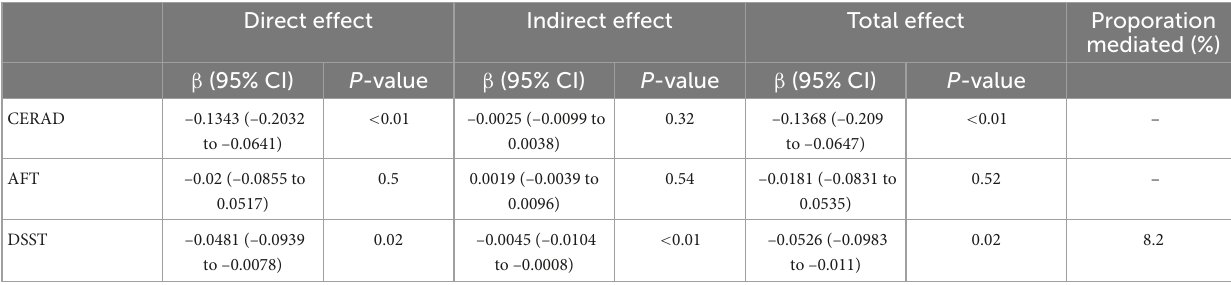
TABLE 9 The mediating proportion of mean PD on the association between α -tocopherol intake and low cognitive